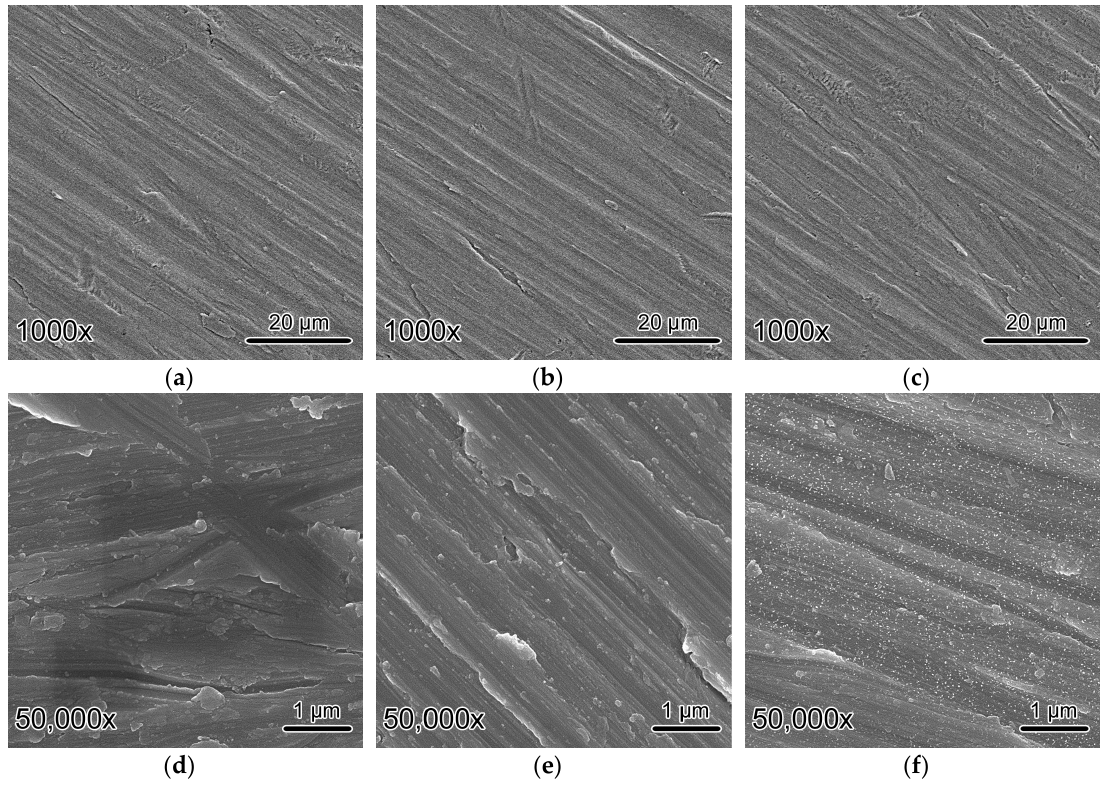
Figure 1. Surface morphology of ( a ) Control; ( b ) Autoclaving (AC); ( c ) Hydrothermal sterilization (HS); ( d – f ), magnified (a–c), respectively.